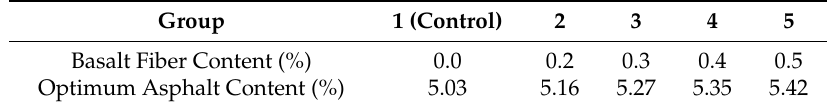
Figure 7. The Marshall design results of asphalt mixture without basalt fiber: ( a ) Bulk specific gravity; ( b ) VA ; ( c ) VMA ; ( d ) VFA ; ( e ) MS ; and ( f ) FL . Table 5. Optimum asphalt content of asphalt mixtures with different basalt fiber